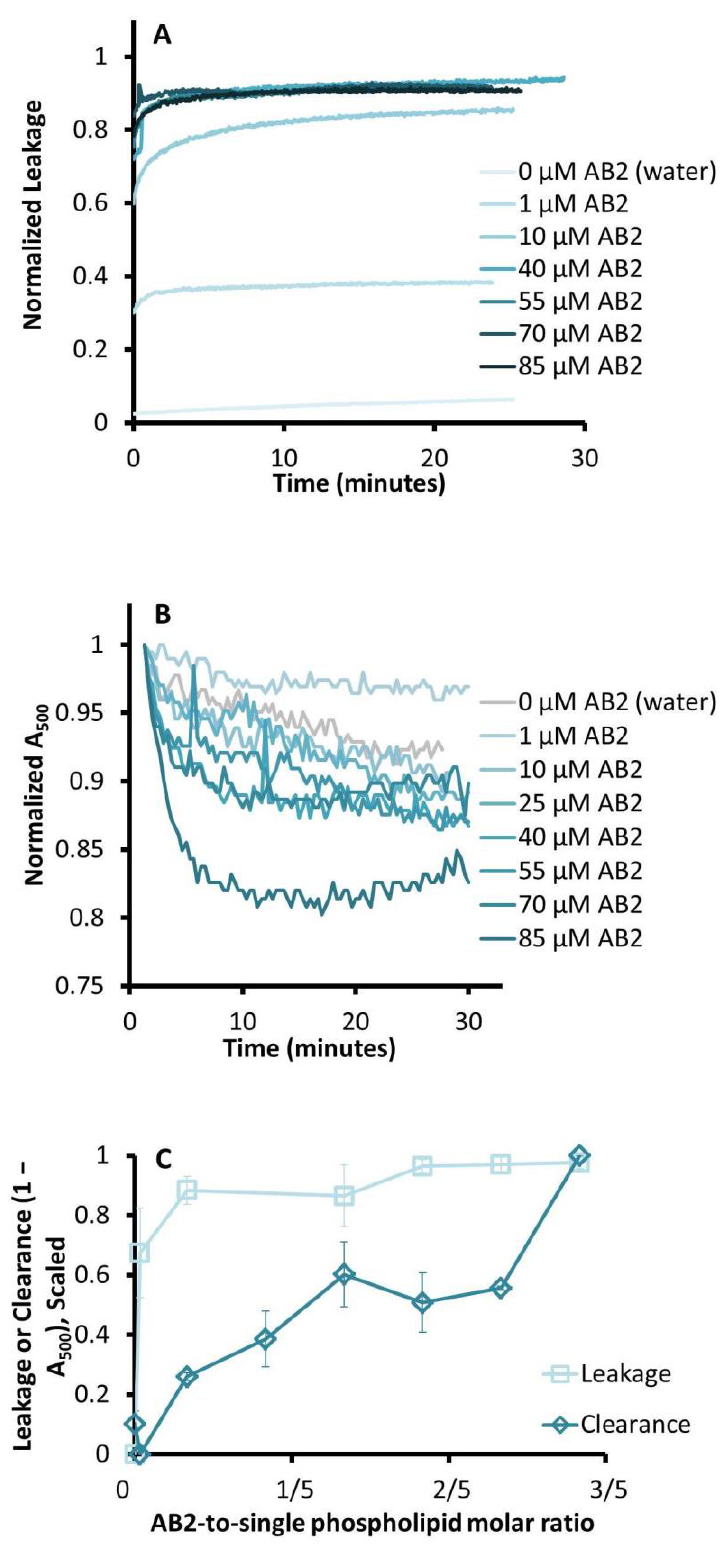
Figure 7. Leakage of 150 µ M LUVs ( A ) and static light scattering of 150 µ M MLVs ( B ) with indicated concentrations of AB2. ( C ) MLV clearance, defined as light scattering loss (blue), and LUV leakage (light blue) at 15 min upon addition of AB2 to vesicles at the indicated peptide-to-phospholipid molar ratios. Error bars represent standard errors of the mean ( n = 3).